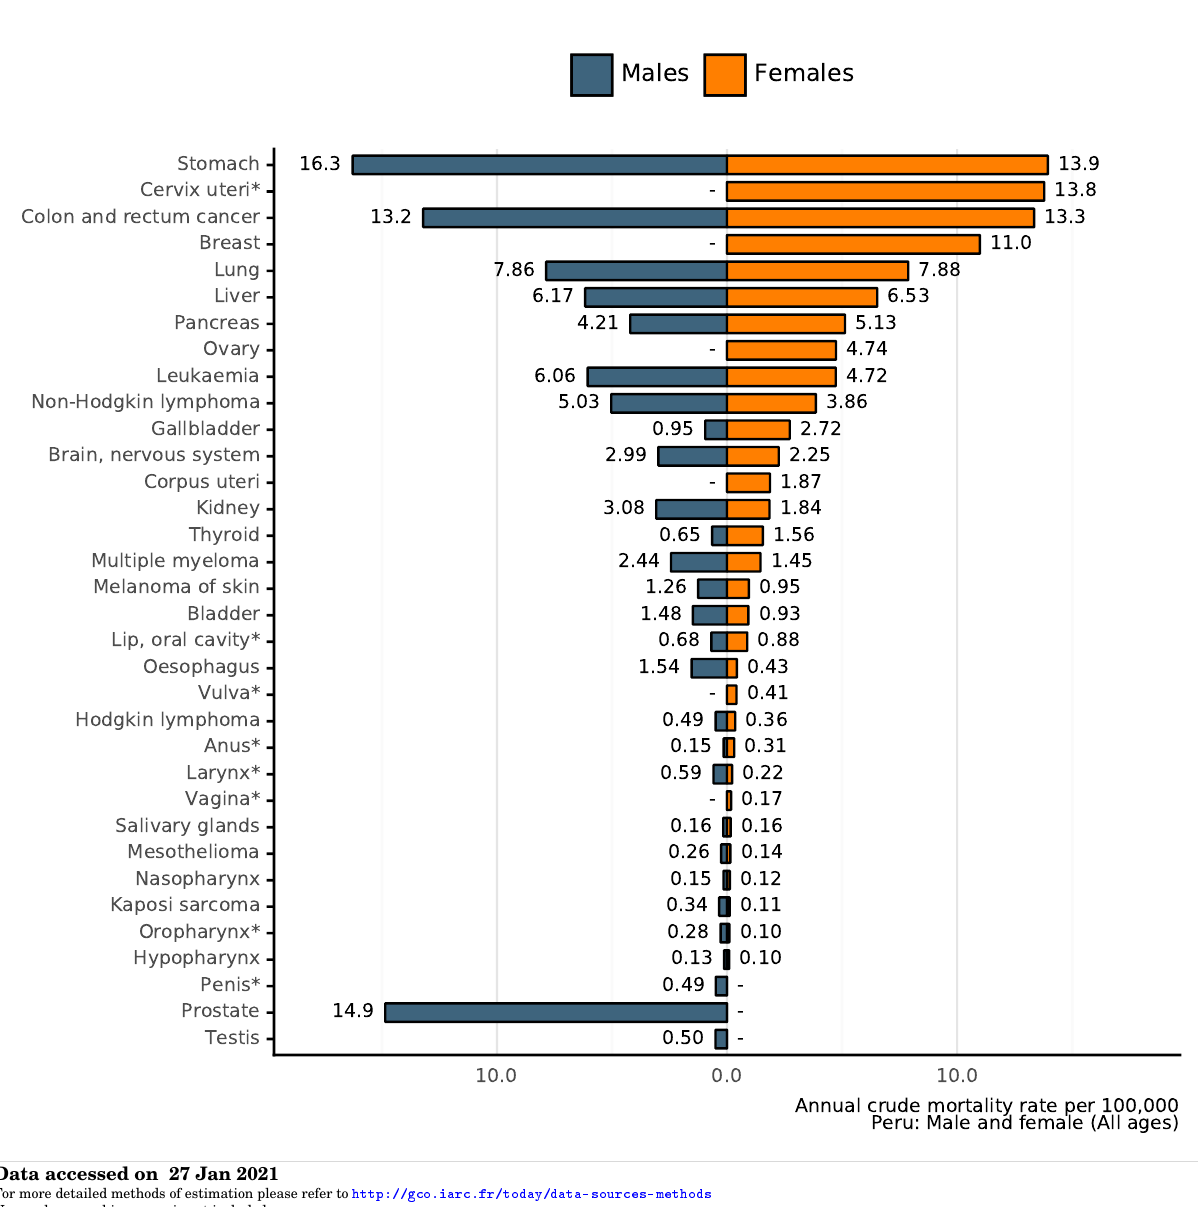
Figure 6: Comparison of HPV related cancers mortality to other cancers in men and women of all ages in Peru (estimates for 2020)